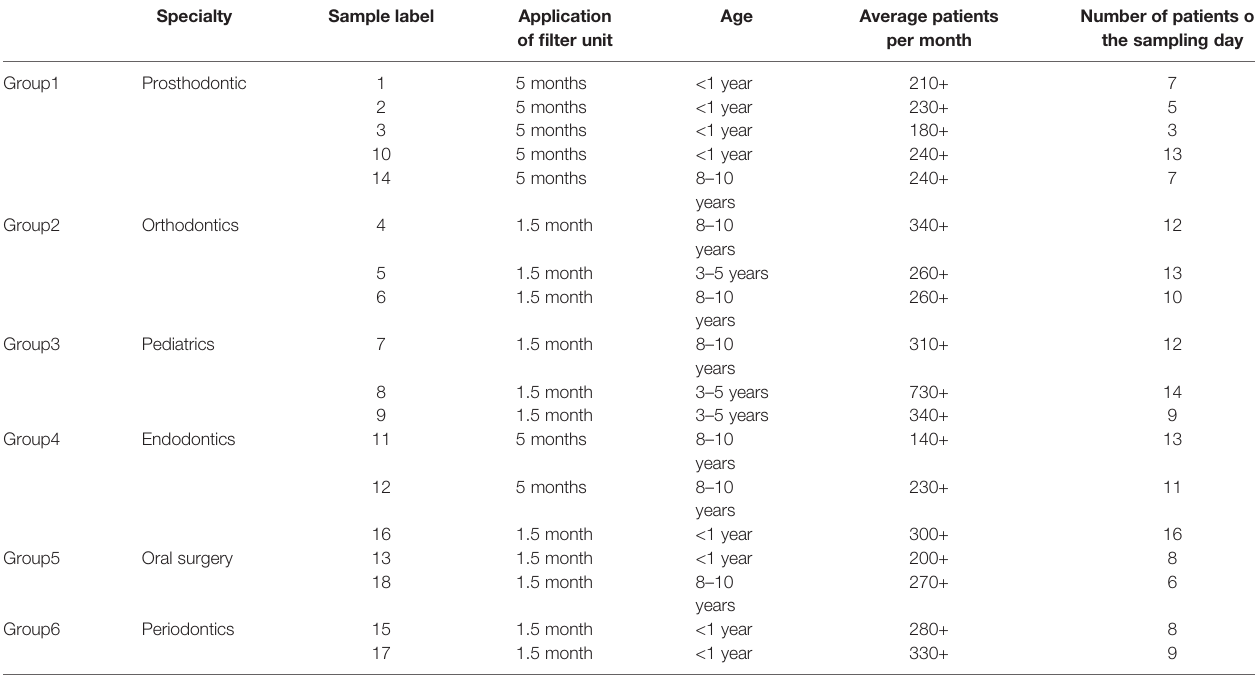
TABLE 1 | The general information of sampling Dental Chair